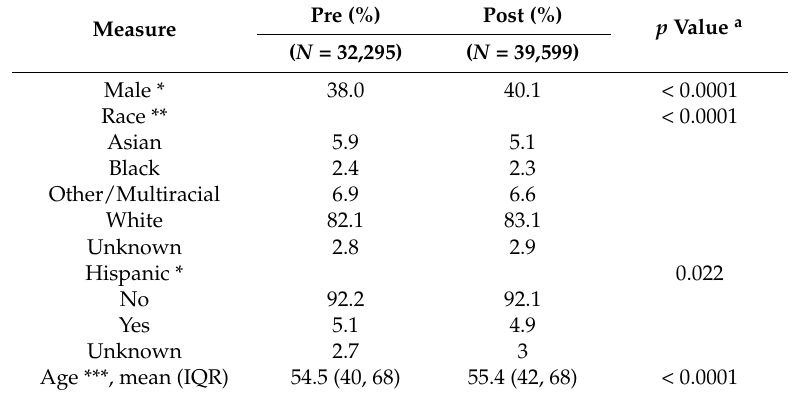
Figure 3. Assessment for alcohol use disorders (AUD): percentage (%) of visits with completed AUD Symptom Checklist by month, among providers implementing Behavioral Health Integration including the Sustained Patient-centered Alcohol-related Care (SPARC) program within three PC sites. Figure 4 . New diagnosis and treatment for alcohol use disorders (AUD): percentage (%) of visits by month, among providers implementing Behavioral Health Integration including the Sustained Patient-centered Alcohol-related Care (SPARC) program within three PC sites.